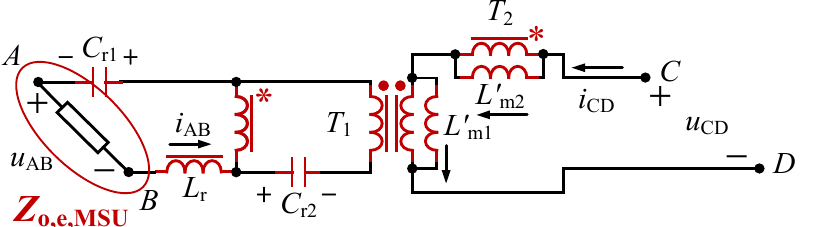
Figure 11. Equivalent FHA circuit in step-up mode. (The symbols of “*” are dotted terminals of T 2 ). The output voltage of the resonant tank in T main , U SU , is shown in List 3 of the Appendix A. With the method of Fourier decomposition, the angle between the fundamental wave of the output AC current i AB and the fundamental wave of the input AC voltage u AB , ϕ is estimated as